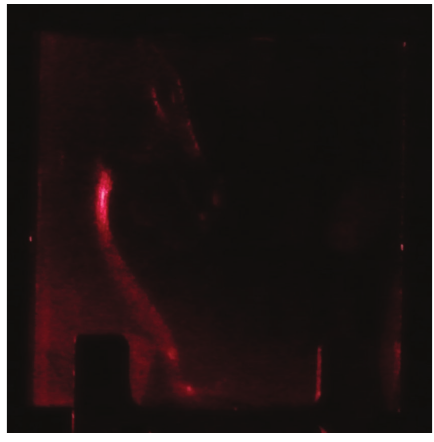
Figure 5: The reconstructed real image is pseudoscopic.